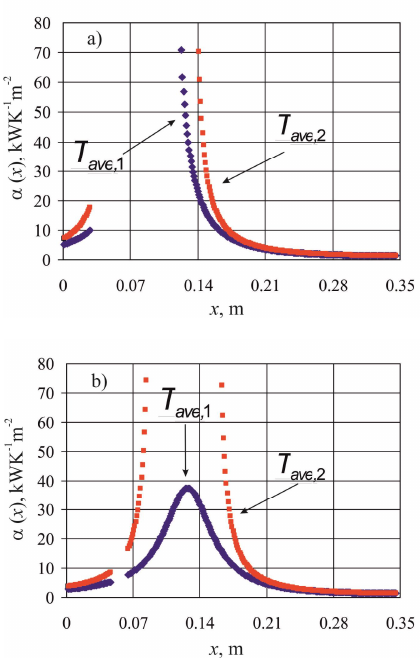
Fig.5 . Heat transfer coefficients as a function of the minichannel height obtained using when the reference temperature is equal to T ave, 1 and T ave, 2 for: a) q V =1.97·10 5 kW/m 3 , b) q V =2.01·10 5 kW/m 3 . Additional data as in Fig. 2 and saturation temperature: 338.5K ‚ 340